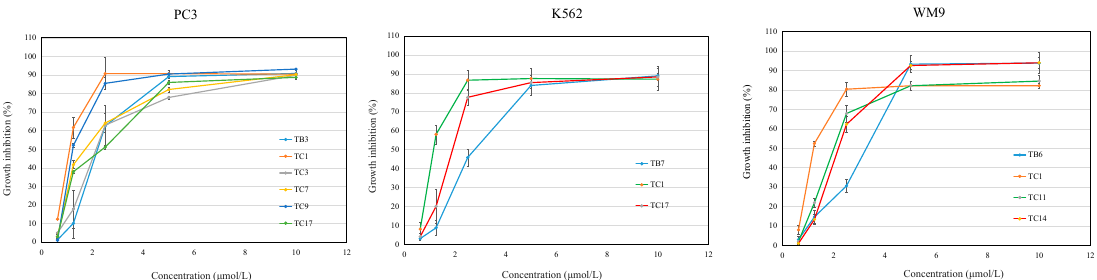
Figure 2. Growth inhibition induced by the active L-shaped ortho-quinone analogs on PC3, K562, and WM9 cells by MTT assay. The IC 50 values ( µ M) of the compounds were determined according to these curves at di ff erent incubation times. The 100 µ L tested compounds were added to 96-well microculture plates and 100 µ L cells (a final concentration of 5 × 10 4 / well) were incubated for 48 h at 37 ◦ C. Cell survival was evaluated by MTT assay. The inhibition ratio (%) was calculated as described in the Methods section. Data was presented as mean ± SD of three independent experiments. Table 2. IC 50 values of selected compounds in Table 1. The structures and inhibitory rates after treating cancer cell lines with 5 µmol/L of target compounds, respectively. Data was presented as the mean ± SD of three independent experiments.